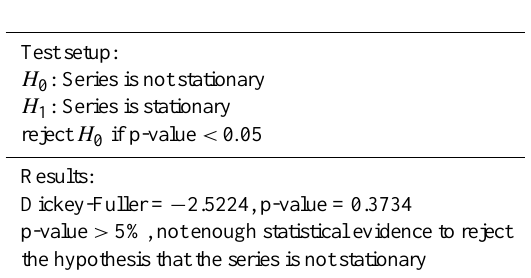
Table 3. Dickey-Fuller Unit Root